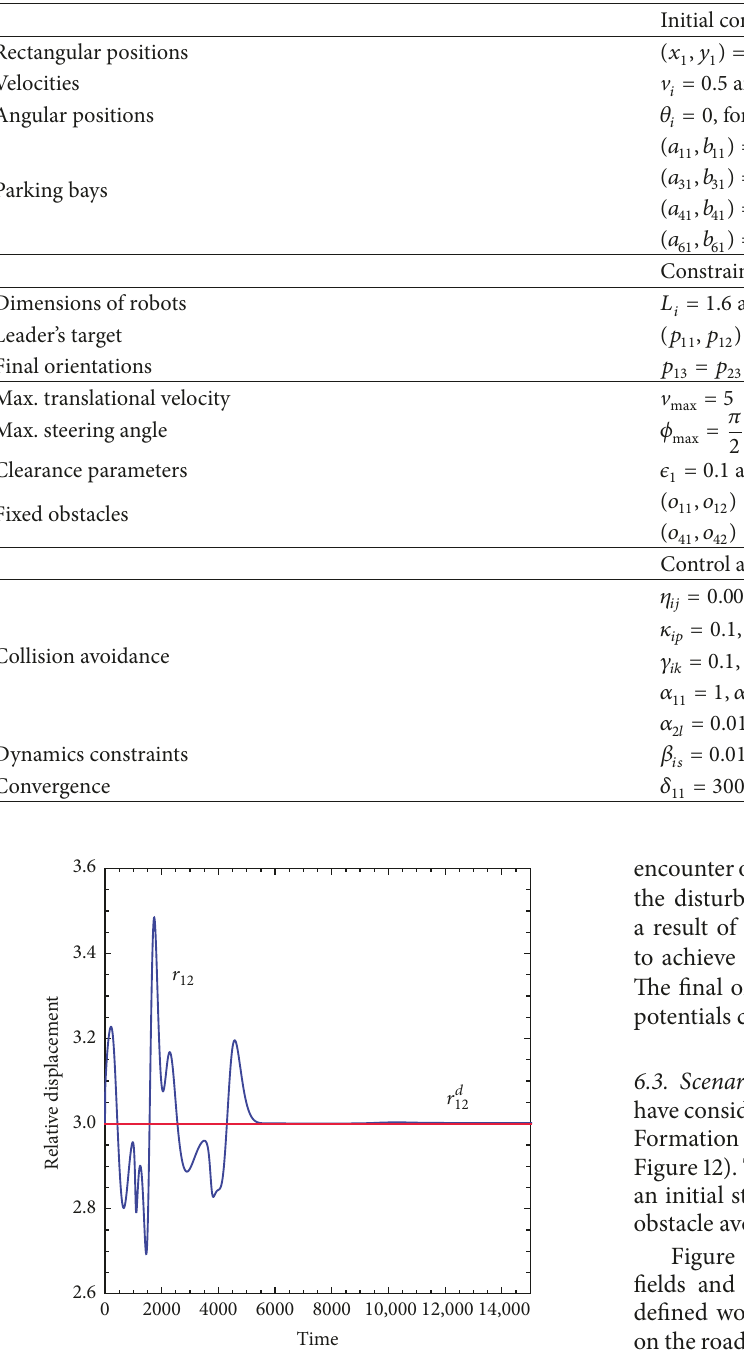
Figure 10: The relative distance of the follower to the leader vehicle compared to the desired relative distance in Scenario